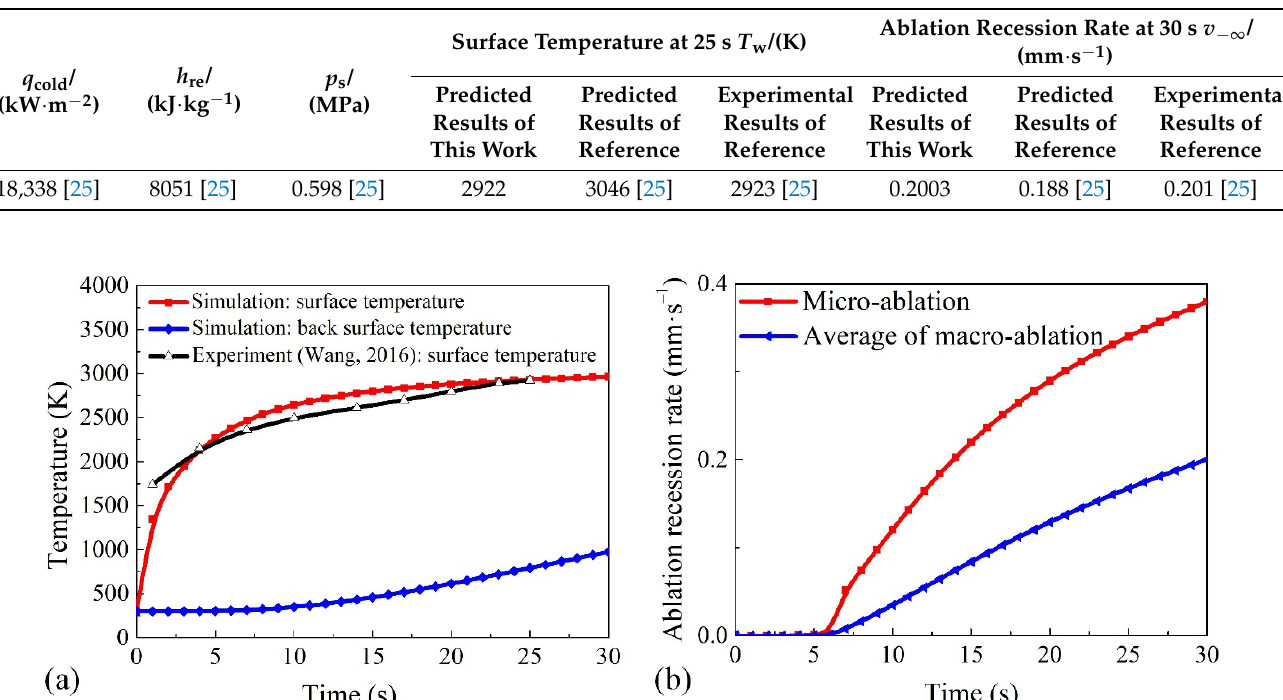
Table 2. Comparison between the predicted and experimentally measured jet arc ablation performance.